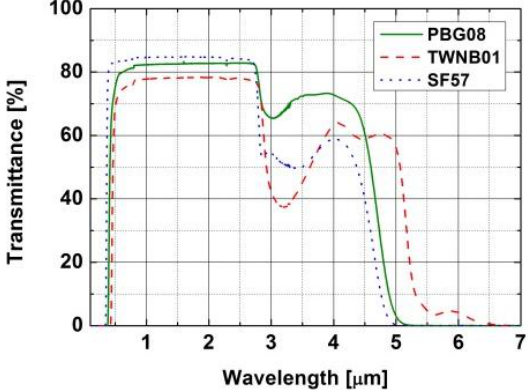
Figure 1. Transmission of lead-bismuth-galate (PBG08) glass. Transmission of tellurite TWNB-01 and commercial lead-silicate SF57 glasses are shown as reference. Bulk sample thickness in all measurements was 2